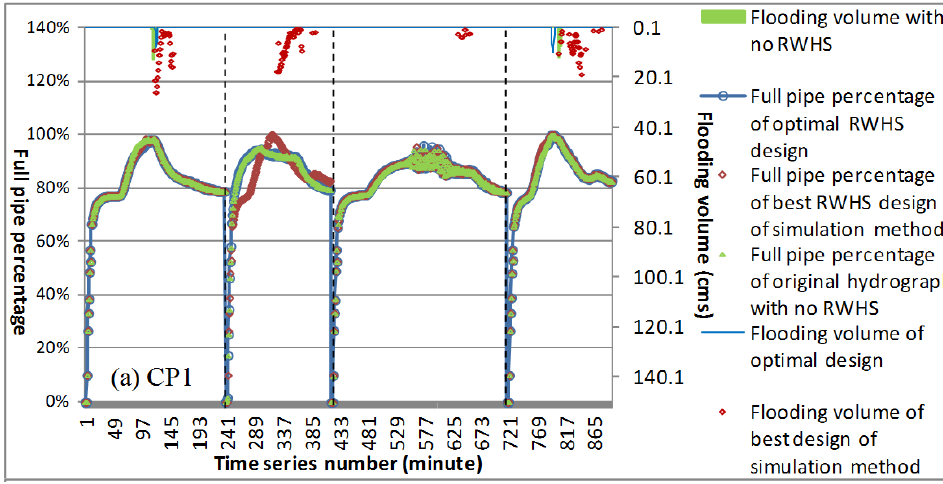
Figure 12. Optimized design results of capacity and quantity of rainwater harvesting systems for Zhong-He drainage system.